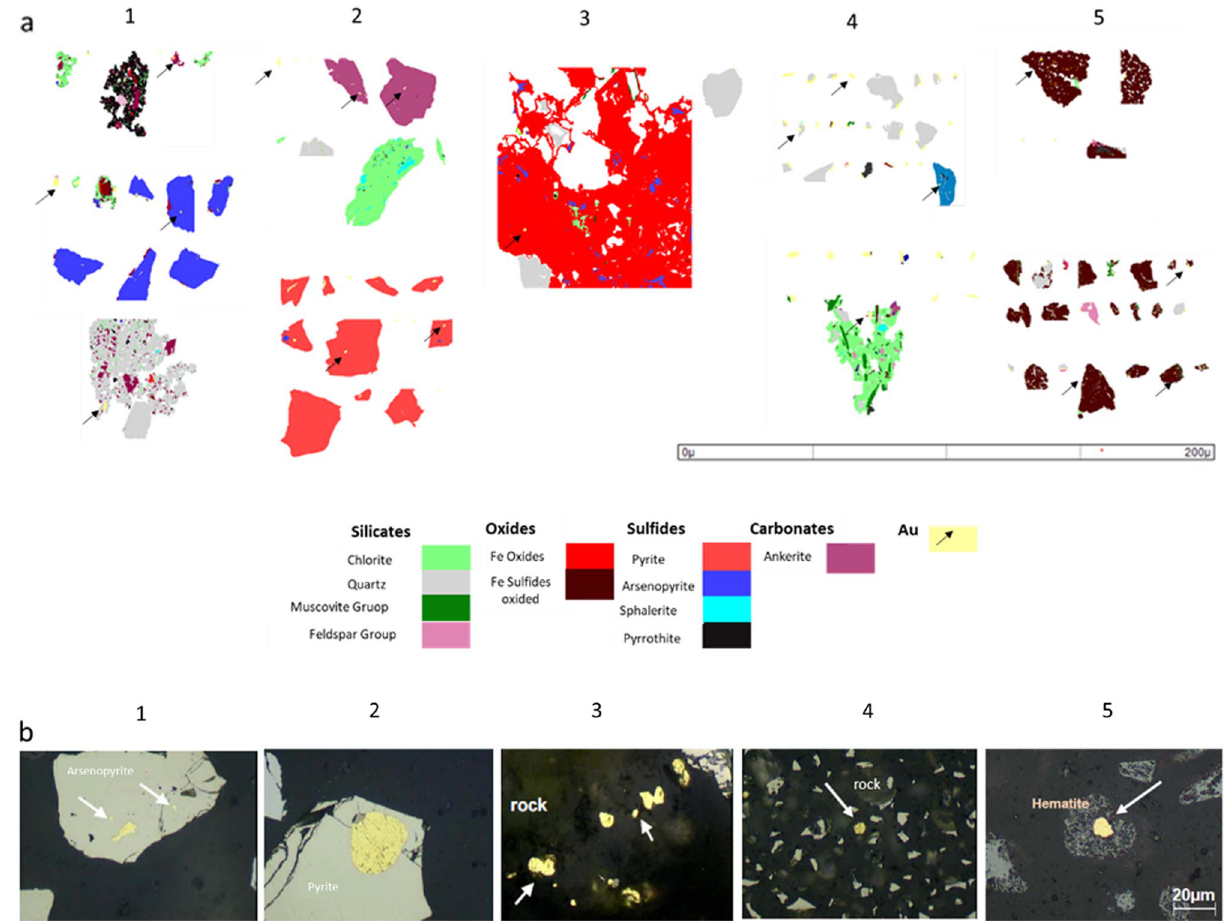
Figure 4. ( a ) False color electron images of Au-bearing particles (yellow and black arrows): Deposit 1— Gold enclosed in pyrrhotite (black), chlorite (green), arsenopyrite (blue) and quartz (gray). Deposit 2: Free and enclosed gold particles in ankerite (purple), chlorite, quartz, and pyrite (dark pink). Deposit 3: Relics of arsenopyrite and gold particles enclosed in iron oxide (red). Deposit 4: Free gold particles and